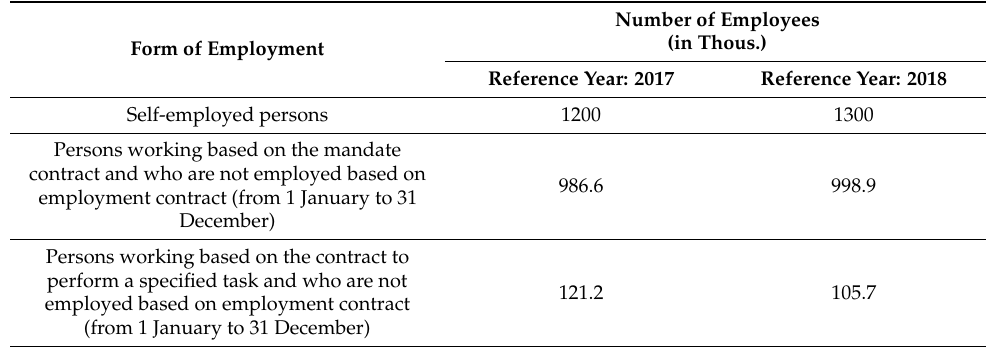
Number of Employees (in